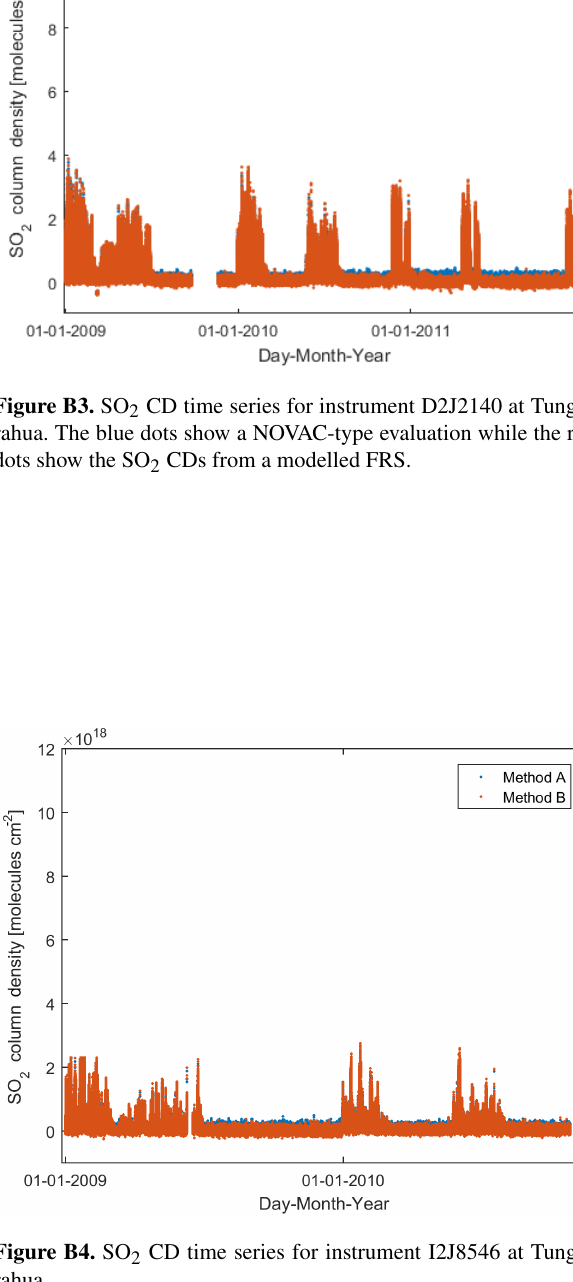
Figure B2. SO 2 CD time series for instrument D2J2201 at Nevado del Ruiz.